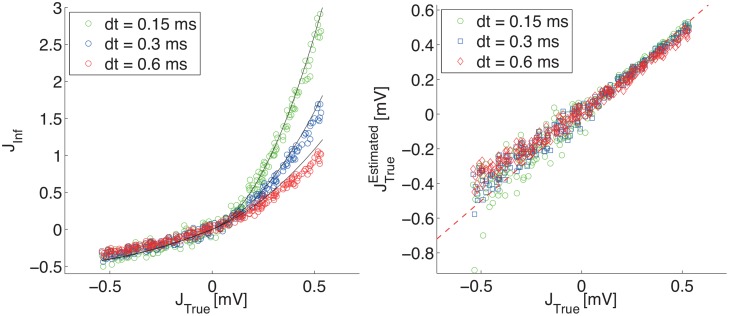
Relationship between inferred couplings and synaptic efficacies for varying time-bin dt.Left panel: J
Inf
vs
J
True. Right panel: JTrueEstimated
vs
J
True. In both cases only non-zero synapses were included. Results are for a network of N
E = 25 excitatory neurons and N
I = 25 inhibitory neurons, sparsely connected with probability c = 0.1, and firing at about 20 Hz; the synaptic efficacies are uniformly distributed in −0.54 mV < J
ij < 0.54 mV; δ
ij = 3 ms.